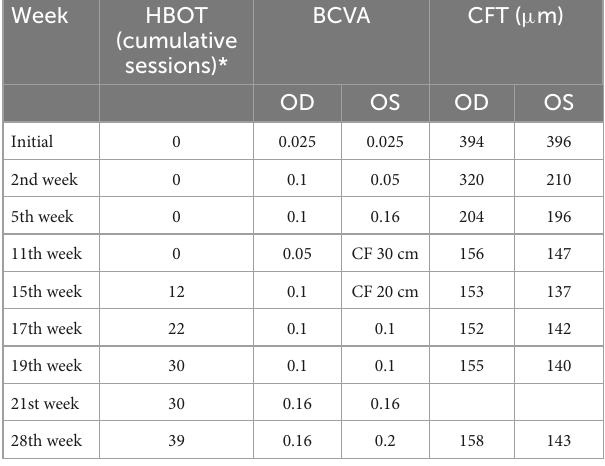
TABLE 1 Hyperbaric oxygen therapy sessions and visual acuity and ocular findings monitoring.